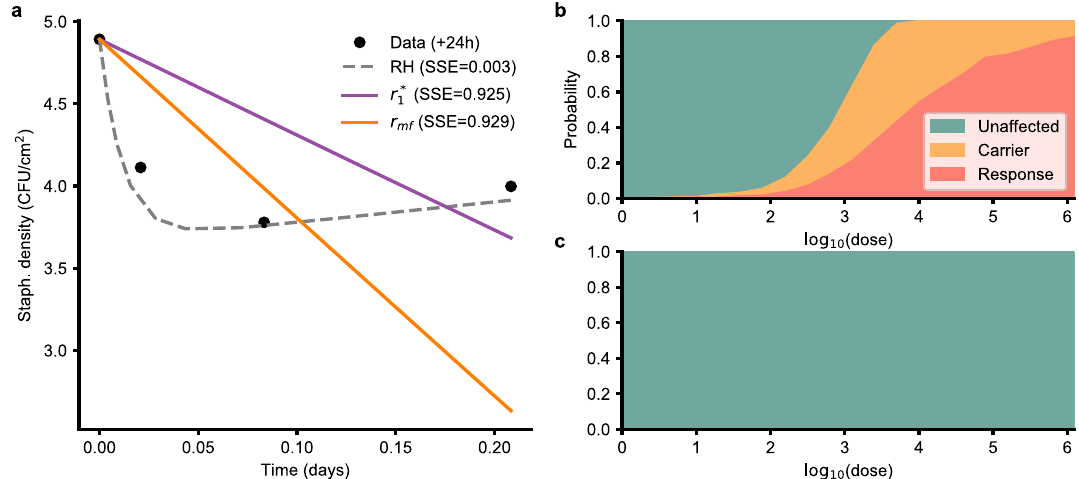
Figure 4. 2C model in the absence of alcohol pre-treatment. Two different hypotheses ( r ∗ 1 and r mf , described in text) were investigated. ( a ) Fit of the two hypotheses to data from Rose and Haas 14 . ( b ) Outcome probabilities for r ∗ 1 hypothesis. ( c ) r mf hypothesis